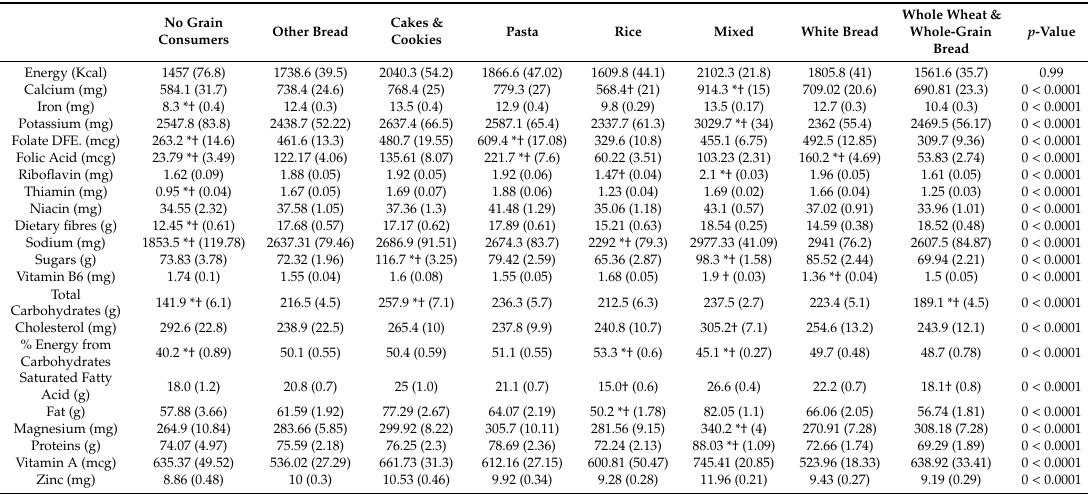
Table 2. Adjusted Adult Mean (SE) Nutrient and Energy Intakes for All Clusters of GBFs.